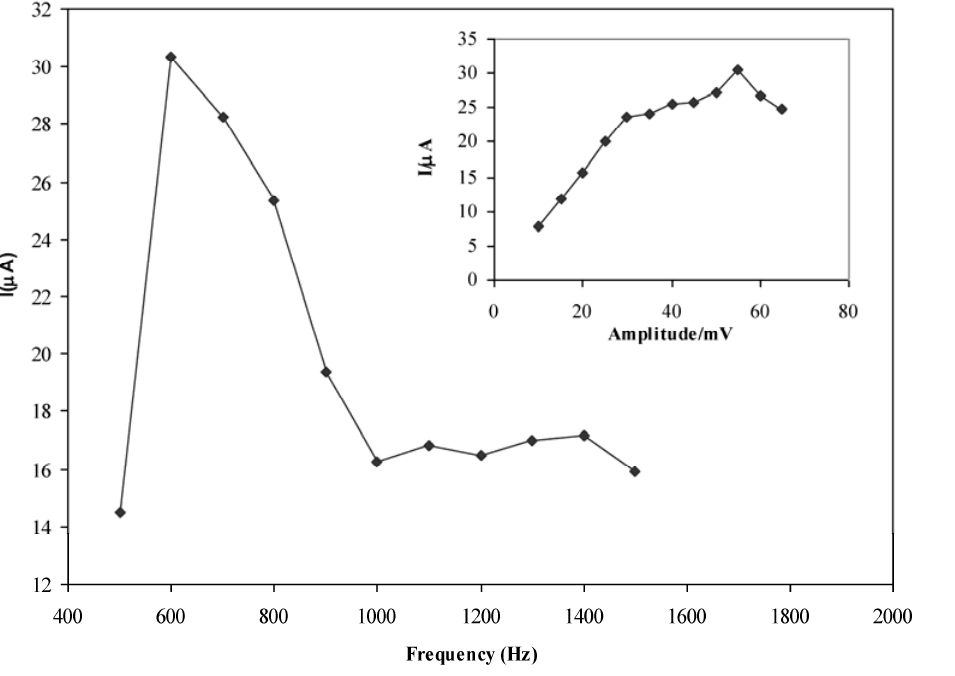
Figure 7. The effect of frequency and amplitude (the inset figure) on the response of CPE for 5.0 × 10 − 7 M diclofenac in 0.05 M of acetate